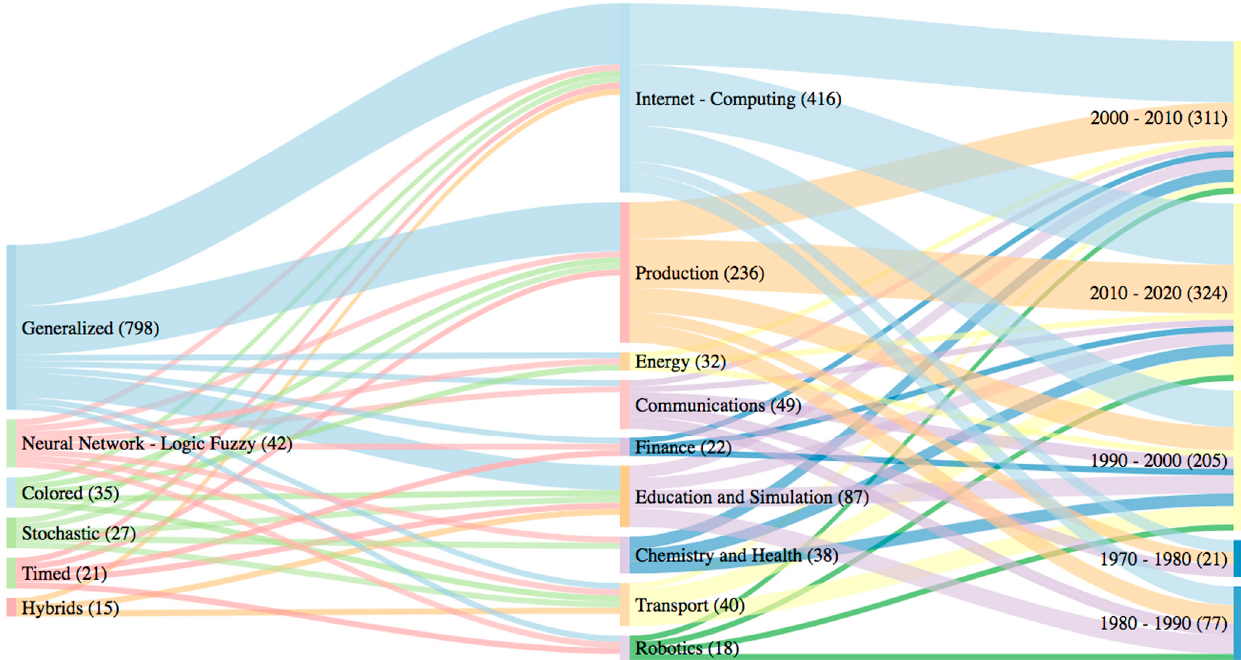
Figure 8. Related patents (PN type–technology development sector–Period).